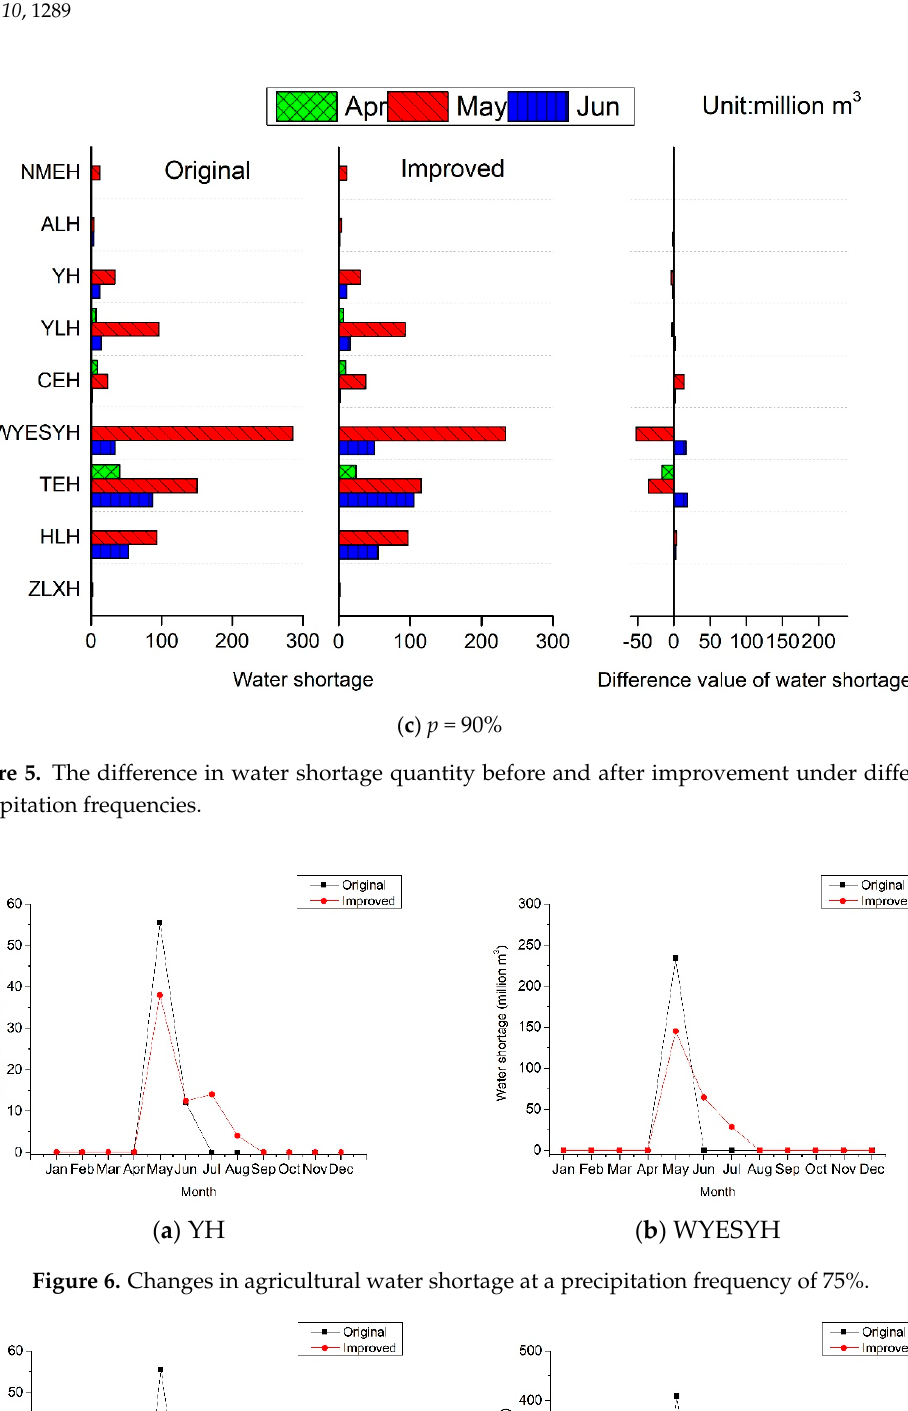
Figure 6. Changes in agricultural water shortage at a precipitation frequency of 75%.